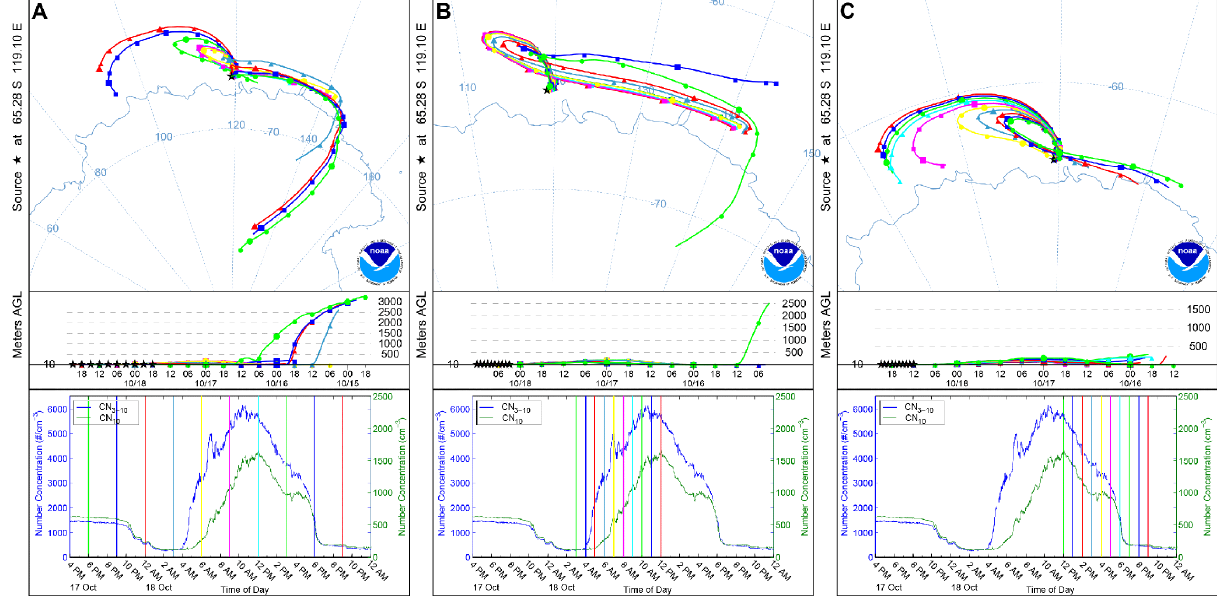
Figure 4. Back trajectories released from 10m (a.s.l.) calculated using NOAA’s HYSPLIT model and driven by GDAS meteorological data, run for 72h during the 18 October particle formation event. Coloured lines in the lower plots show the release time of the trajectory relative to the particle concentration. (a) Ten trajectories, one released every 3h between 17 October 18:00 and 18 October 21:00, show the air-mass change from a south-east background, to a more local influence, then back to background from the west. (b) Released hourly and spanning the increase in particle number concentration, between 03:00 and 12:00 18 October, trajectories show that air masses recirculate to the north-west of the ship after travelling along the sea ice surface. (c) Hourly trajectories during the decrease in particle number concentration, between 12:00 and 21:00 18 October, show the local impact steadily being diluted as influence from further west increases. The fastest drop in aerosol concentration is found to occur when recirculation ceases and westerly influence